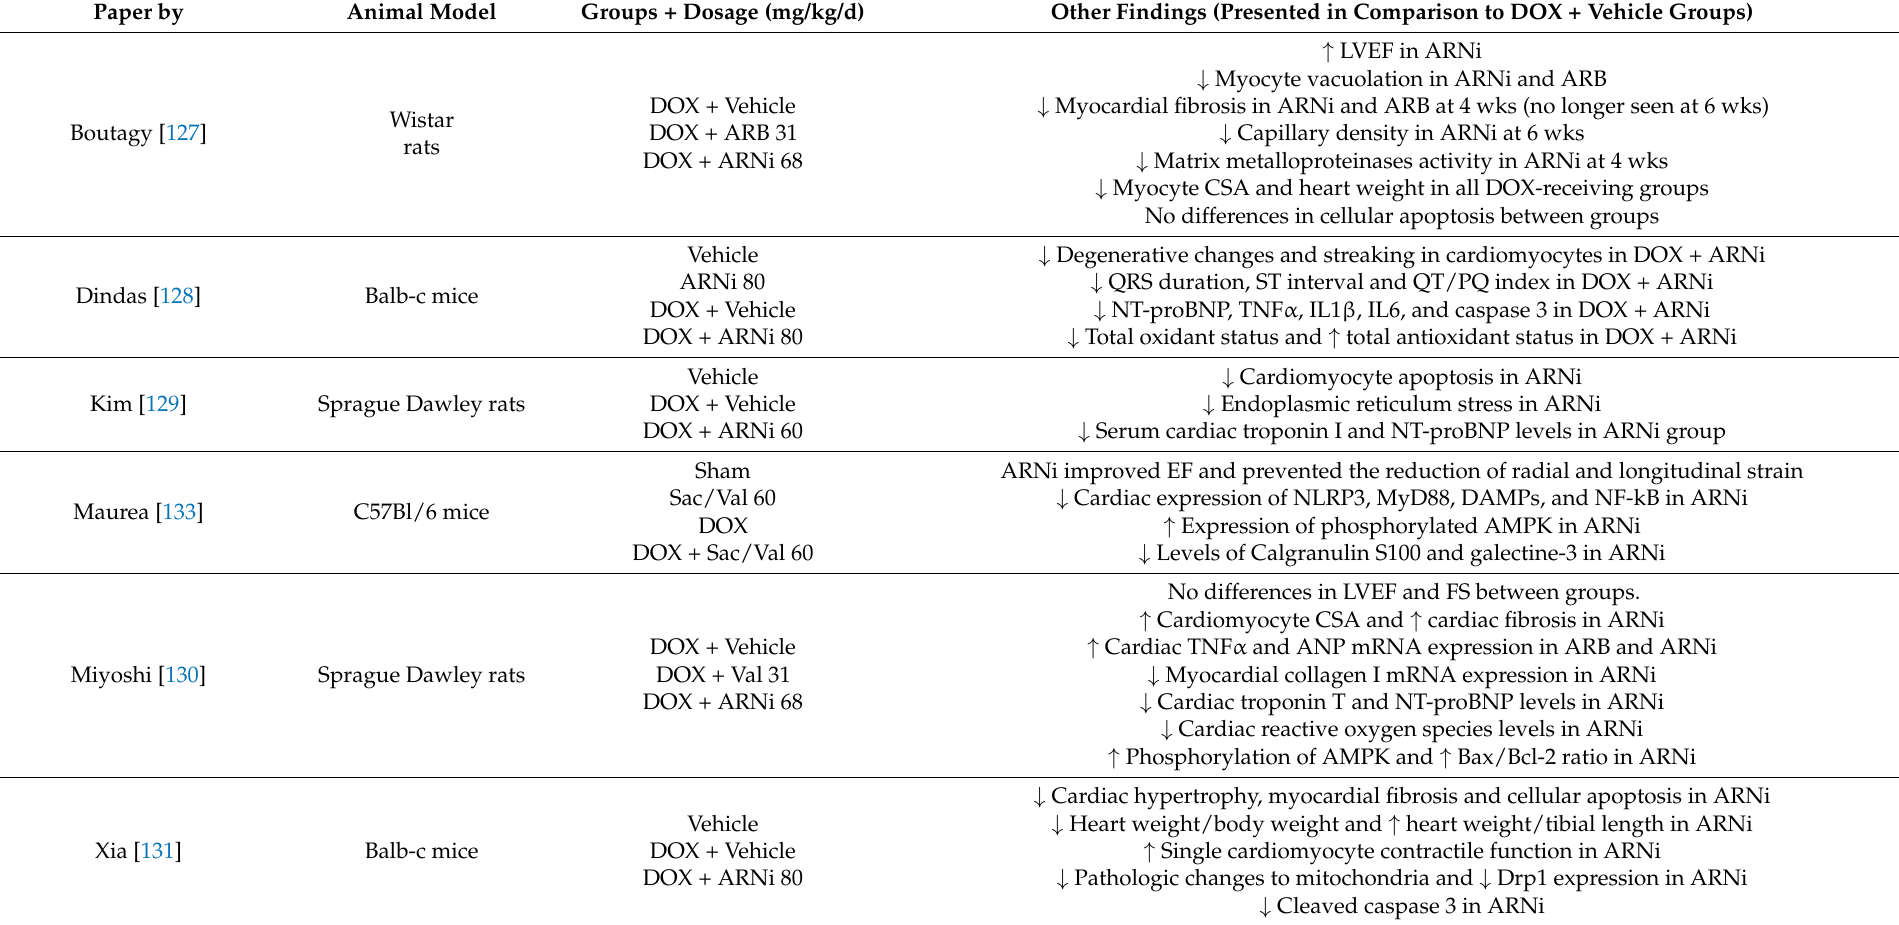
Table 3. ARNi administration in animal models of anthracycline-induced